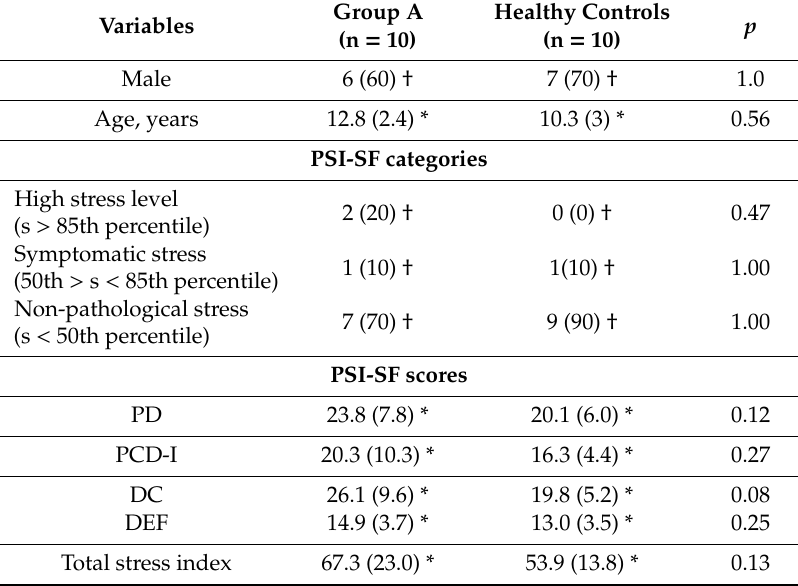
Table 2. Results of PSI-SF questionnaire administered to the mothers of Group A patients and